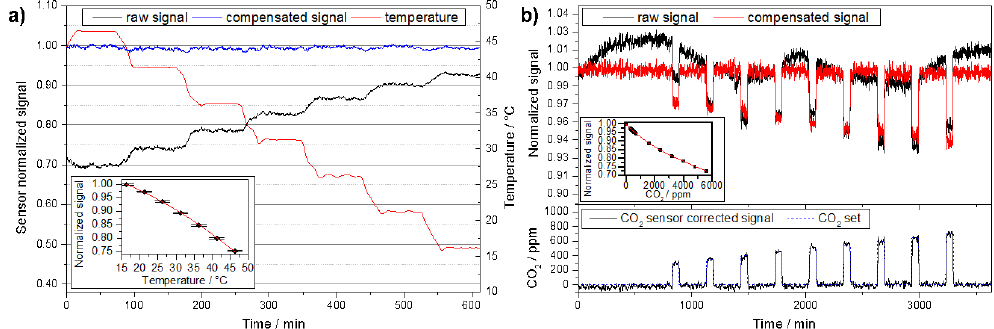
Figure 3. ( a ) Temperature calibration using a climatic chamber to enable corrections for changes in ambient temperature during operation of the sensor module. The blue curve shows the corrected signal. ( b ) Using a certified gas mixture the dependence of the sensor response on different CO 2 concentrations has been established.